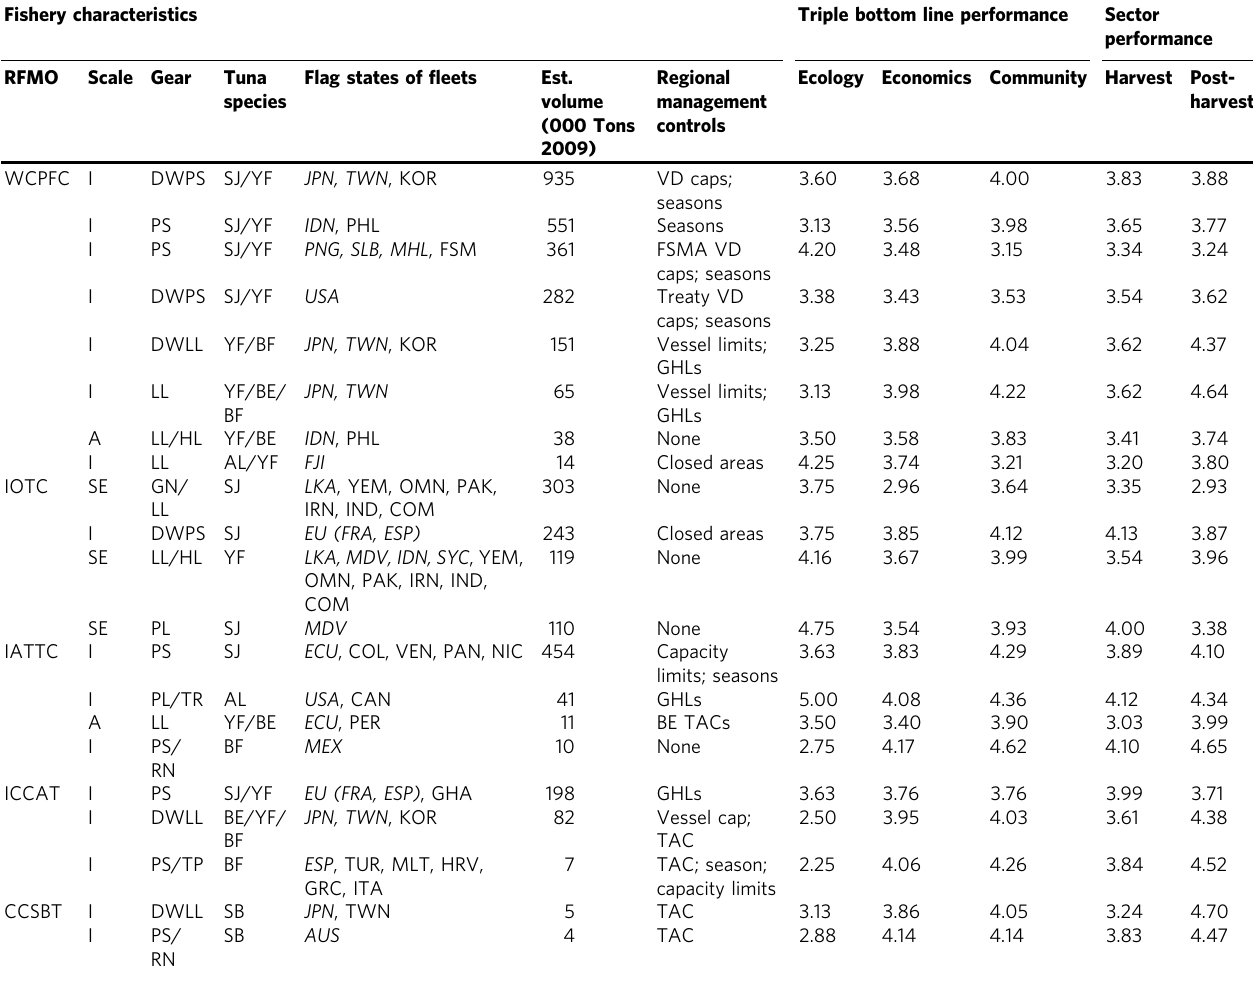
Table 1 Characteristics of 21 global tuna fi sheries and their performance outcomes by triple bottom line and by sector Fishery